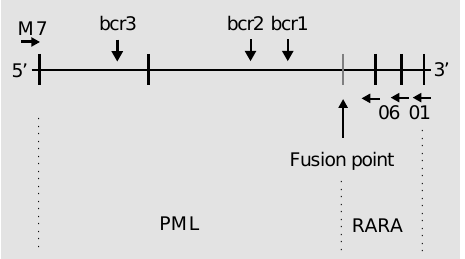
Figure 3. Schematic diagram of the localization of the primers in the PML/RARA cDNA fusion (10).